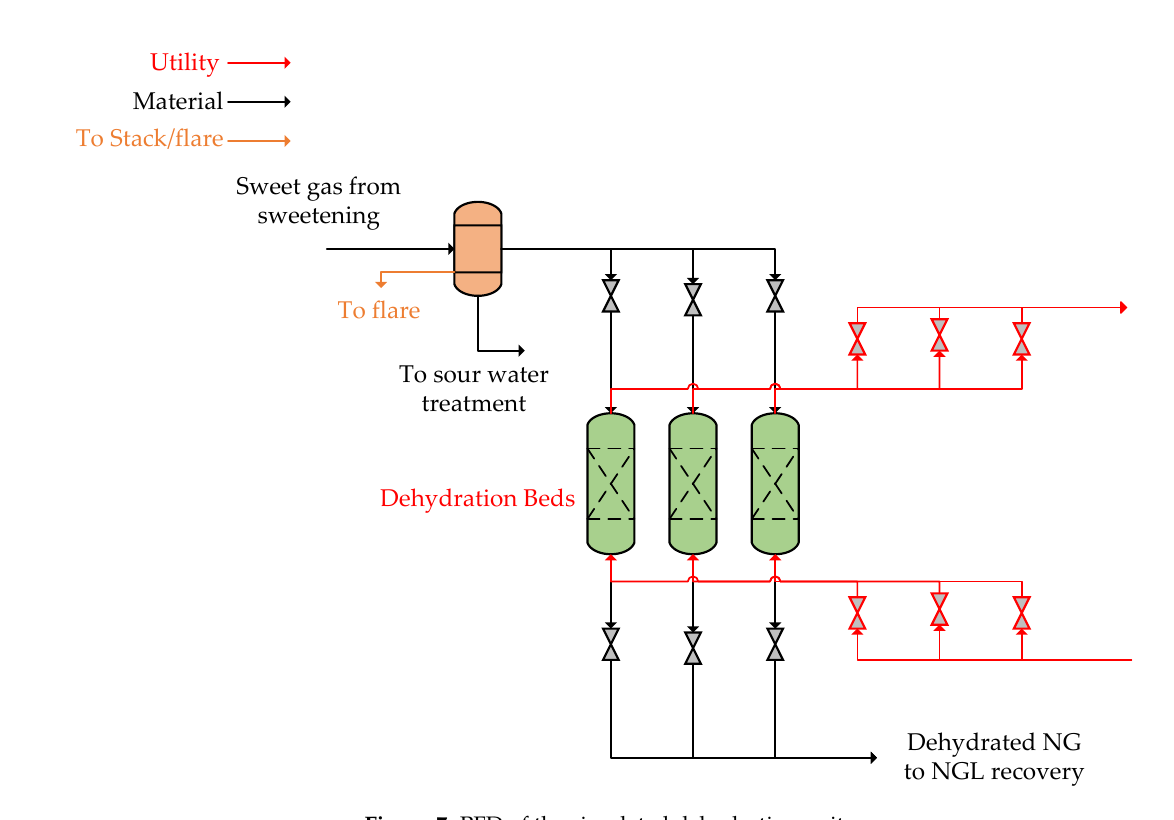
Figure 7. PFD of the simulated dehydration unit. Table 6. Dehydration unit conditions and